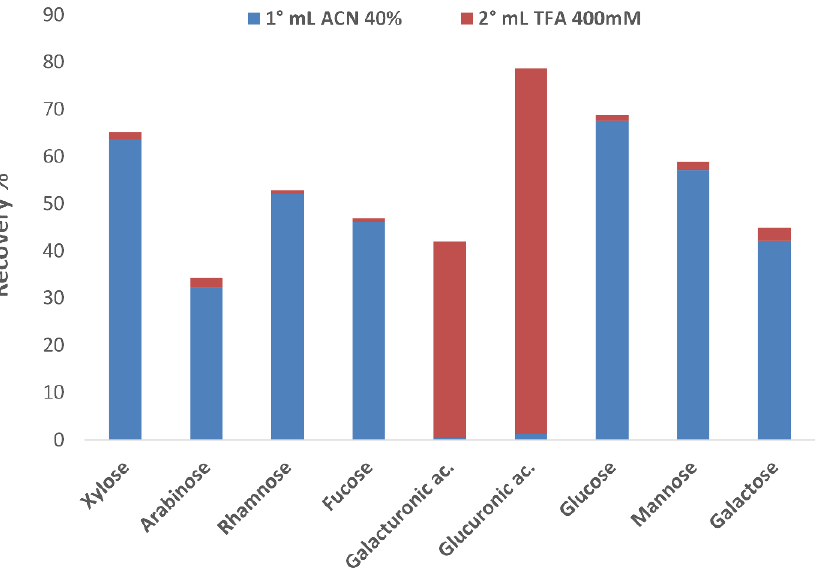
Figure 3. Recoveries, expressed as a percentage with respect to the concentration of starting solution, reported for each fraction of eluate analyzed, relative to the clean-up test results (Experiment B) using a Macherey-Nagel™ Chromabond™ NH2 Polypropylene SPE column applied to a standard solution of 7 monosaccharides and 2 uronic acids (each at 10 ppm). The experiment was conducted in triplicate and the error bars represent the confidence interval.